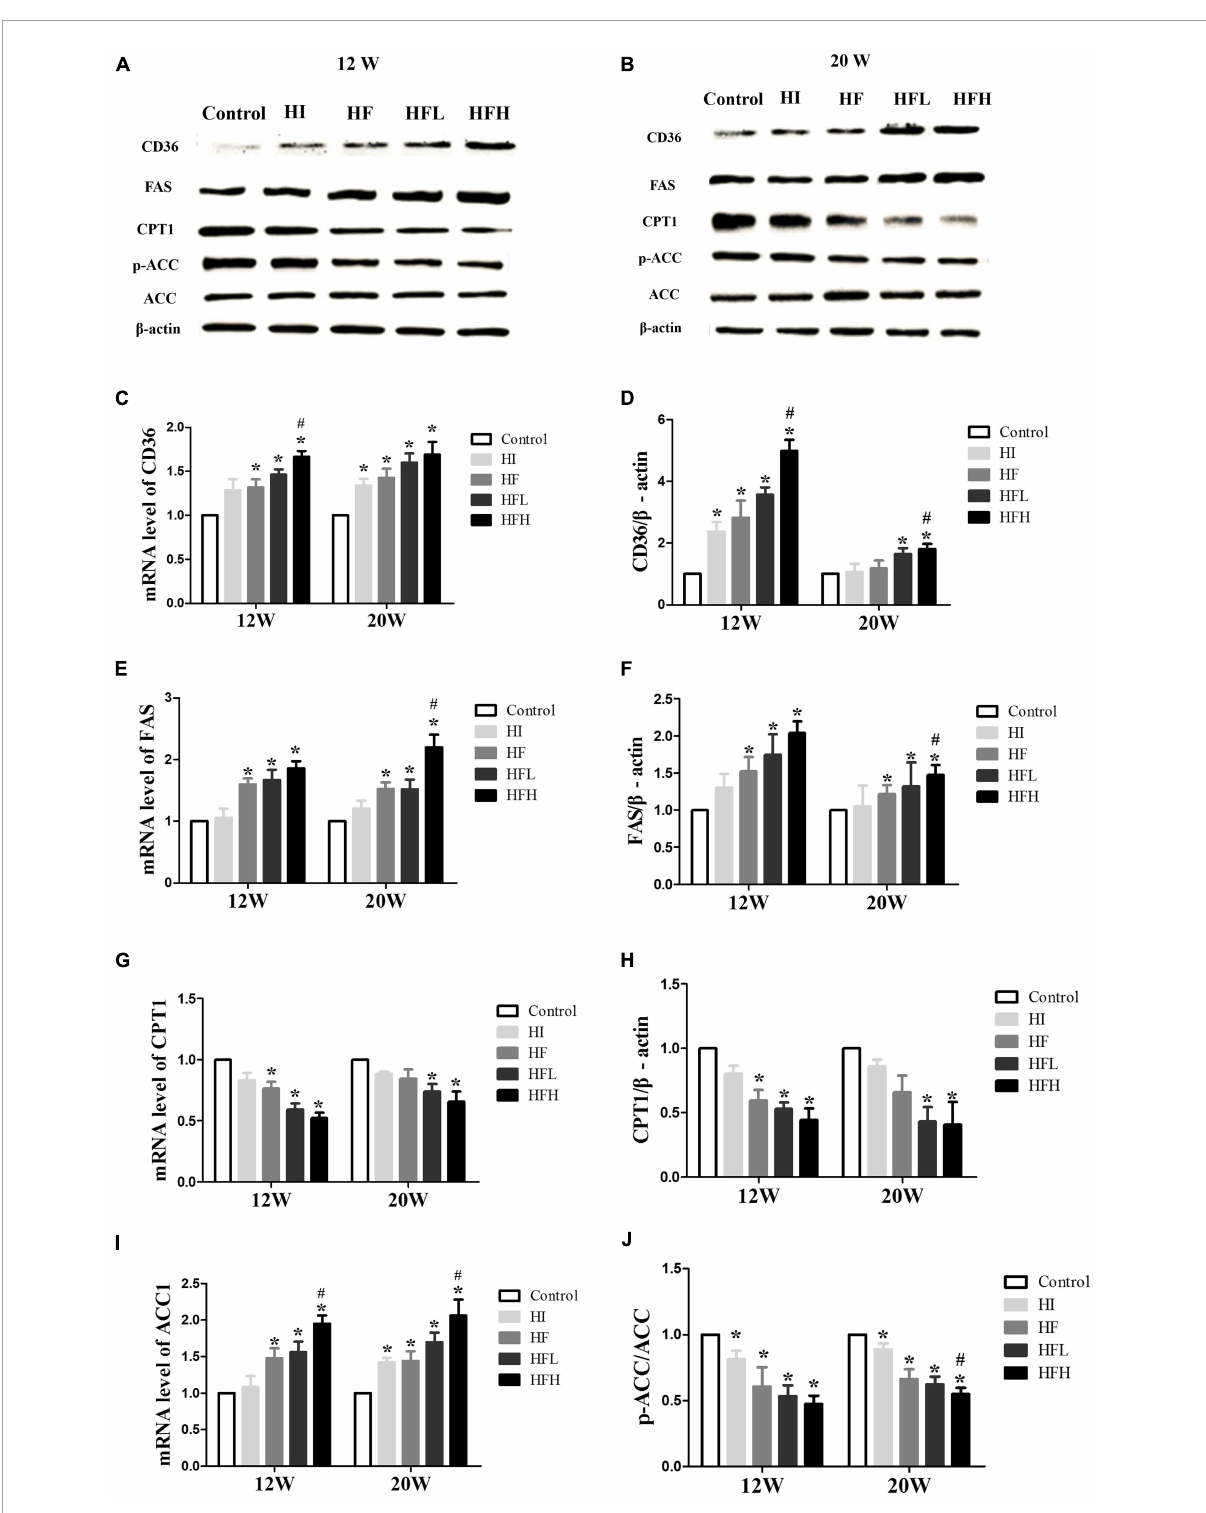
FIGURE5 High-fat and high-iron diets affected fatty acid uptake and synthesis. (A–J) CD36, FAS, CPT1, and ACC mRNA and protein expression levels in the liver of rats. * and # compared with control/high-fat group at the same time point, respectively, P < 0.05